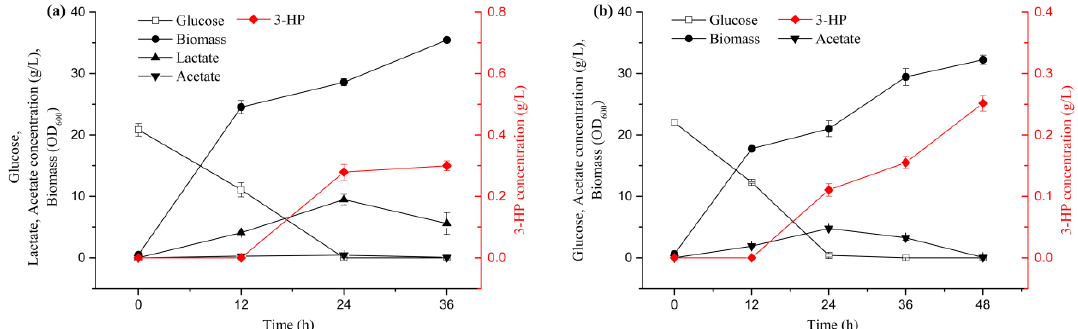
Figure 2. Time profiles of the biomass (filled circles), glucose (open squares), acetate (filled downward triangles), lactate (filled upward triangles) and 3-HP (red filled diamonds) concentrations of strains Cgz1 and Cgz3 grown with 20 g / L glucose. ( a ) Strain Cgz1. ( b ) Strain Cgz3. Error bars indicate the standard deviations from three independent cultures.